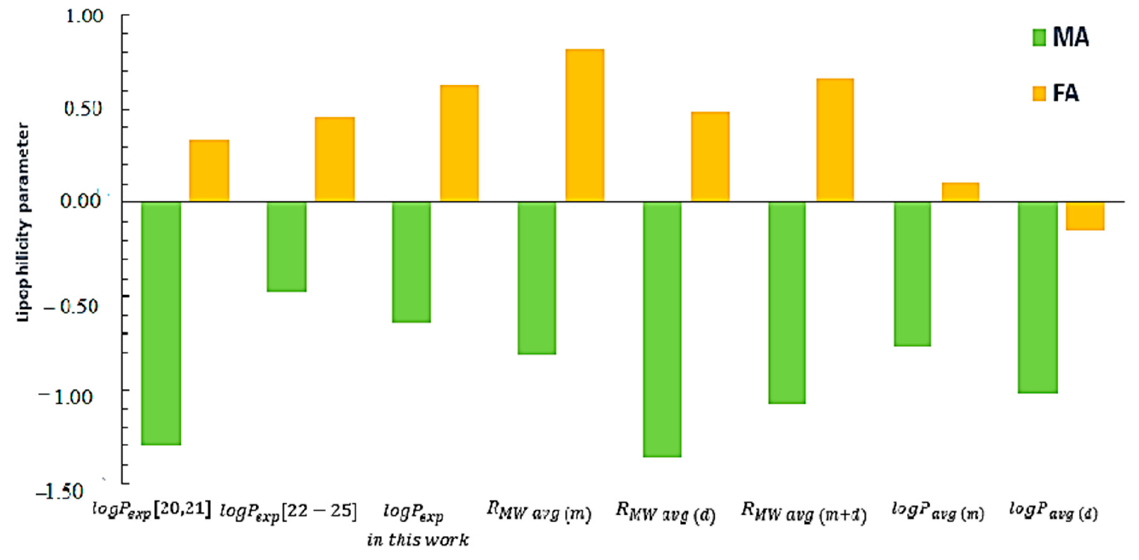
Figure 3. Comparison of the lipophilicity of FA and MA obtained in this paper and by different methods within the literature data.